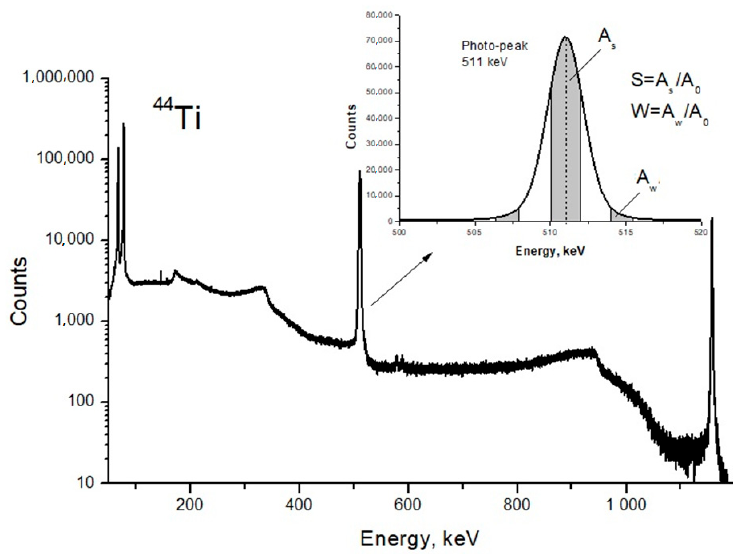
Figure 3. Energy spectrum of scintillator BaF 2 detector and line shape parameters of the photo-peak.